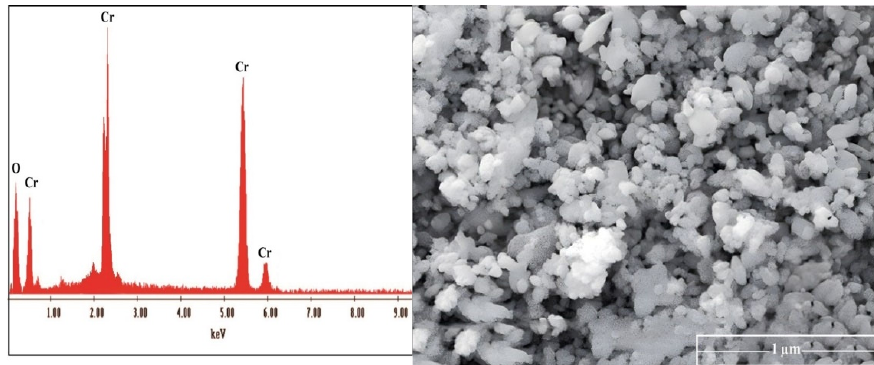
Figure 16. EDAX and SEM of the prepared chromium oxide from tannery wastewater.